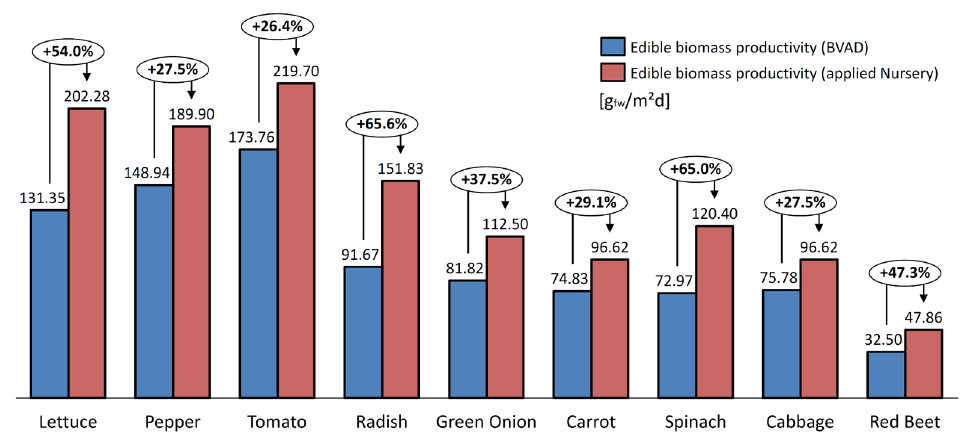
Figure 20: Edible biomass productivity comparison between BVAD (Anderson et al. 2015) (dark blue bars) and simulation results (SC approach, red bars). Observed increase in biomass productivity (fresh weight) by implementing a nursery in comparison to BVAD baseline values. Cucumber and herbs were excluded from this comparison, since no values were present within the BVAD data set. Simulation results were normalized for